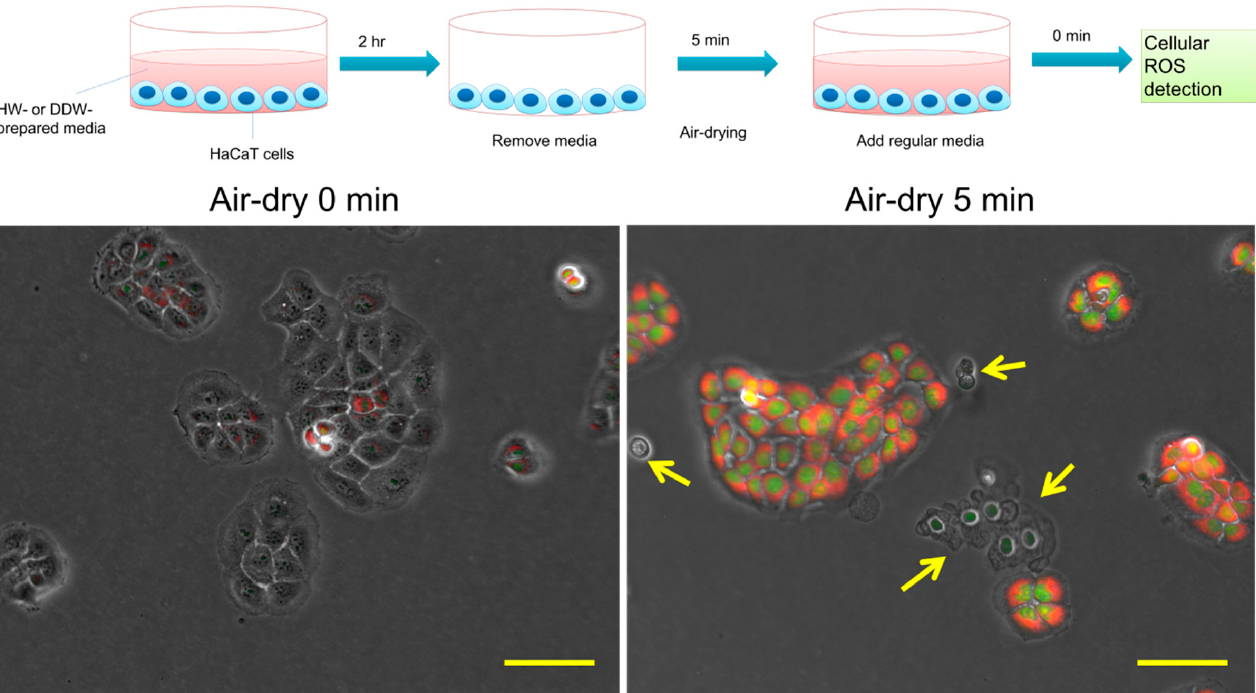
5 Figure 1. Effects of hydrogen-rich water (HW) on hypohydration-induced cell death in human skin keratinocytes HaCaT. HaCaT cells (2 × 10 4 cells/well) were seeded into 24-well plates and cultivated for 48 h. Cells were then cultivated in DDW- or HW-prepared medium for 2 h. After the medium was removed, cells were air-dried for 5, 10 and 20 min, and then re-soaked in the regular culture medium. Cells were further cultivated for 48 h and followed by PrestoBlue ® assay and Giemsa stain- ing. Illustration on the top represents procedures of the experiments. ( A ) Typical phase-contrast microscopic images of HaCaT cells immediately after drying. Scale bars = 20 µm. Cell shrinkage and fragmentation were observed in 20 min dehydrated DDW-pretreated cells, as shown by yellow ar- rowheads. ( B ) Typical images of HaCaT cells stained by Giemsa solution in a 24-well plate. ( C ) Cell